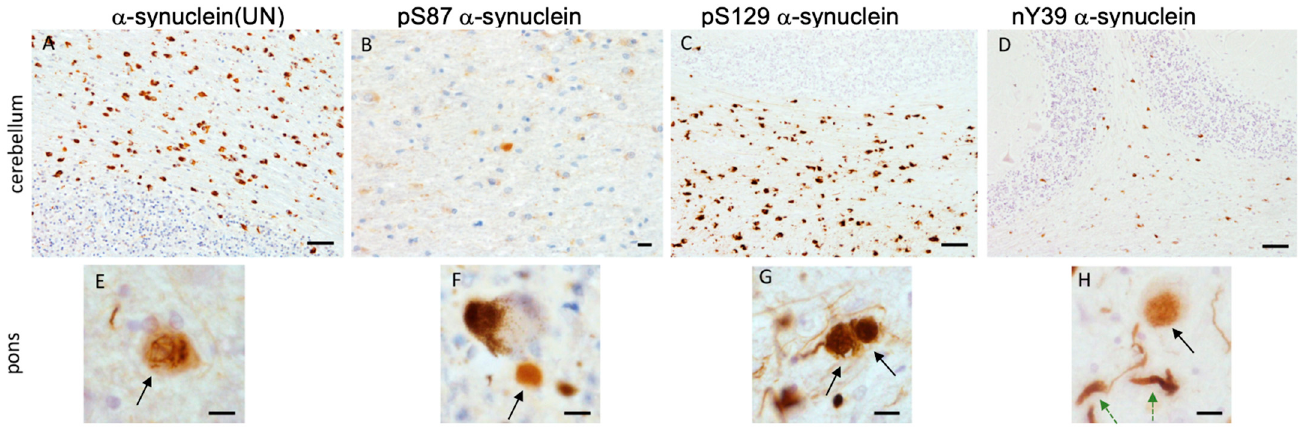
Figure 4. Illustration of immunostaining for different α -synuclein antibodies in cerebellum and pontine base of MSA cases. Immunostaining with α -synuclein unmodified antibody depicting numerous GCIs in the cerebellar white matter in ( A ) and neuronal nuclear inclusion and neuronal cytoplasmic inclusion (black arrow) in ( E ); few GCIs positively stained for S87P α -synuclein in CBM ( B ) and extracellular staining in pontine base ( F ); pS129 α -synuclein marks several GCIs in cerebellum ( C ) and NCIs (black arrow) and fine neurites in pontine base ( G ); nY39 α -synuclein labels fewer GCIs in cerebellum ( D ) and NCIs (black arrow) and thick (green dashed arrows) and thin neurites in ( H ). Scale bars denote 20 μ m in ( A , C , D ), 10 μ m in ( B ), 8 μ m in ( E , G ), and 5 μ m in ( F , H ).